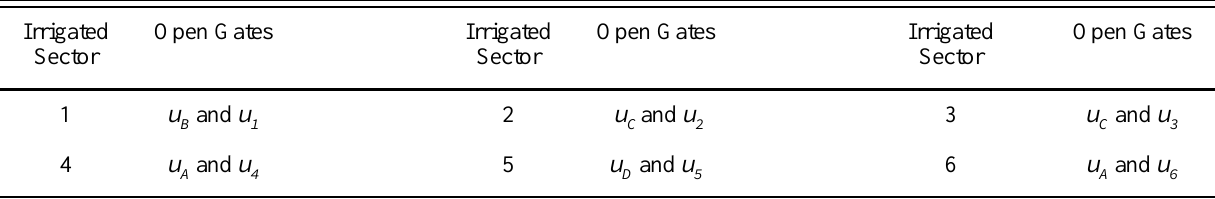
Table 1 . Relationships between gate openings and sectors receiving